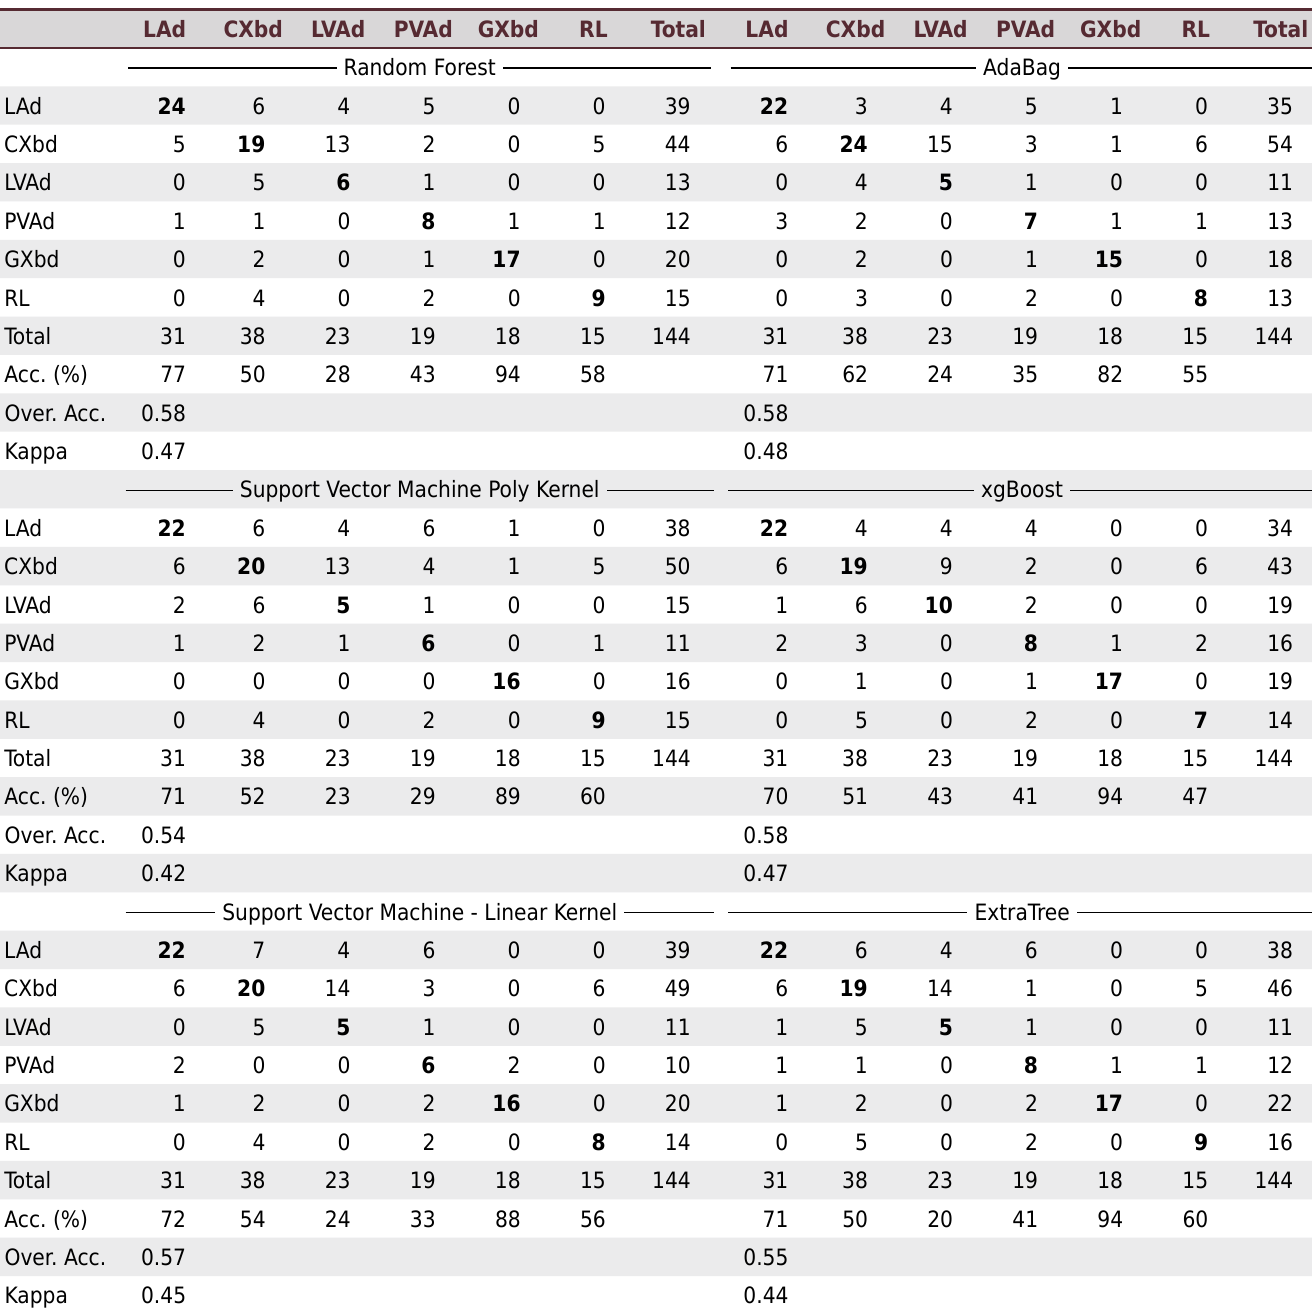
Table 2. Confusion matrixes of soil mapping with each machine learning algorithm